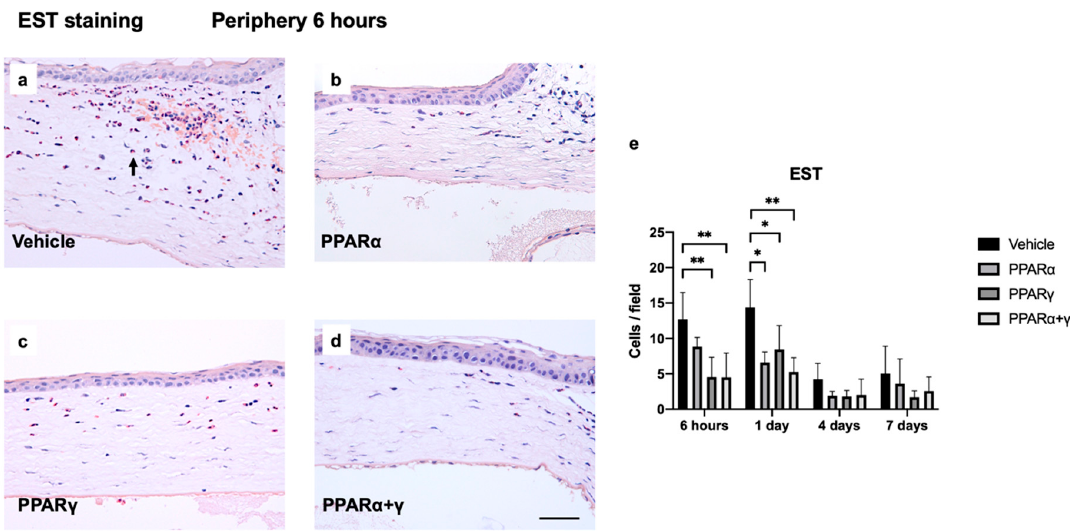
Figure 4. Esterase (EST) staining was performed to evaluate infiltrating cells in the rat cornea after alkali injury. Immunohistochemical images of the corneal limbus at 6 h are shown ( a – d ). Bar, 50 µ m. The black arrow indicates EST-positive cells ( a ). PPAR γ and PPAR α + γ treatment reduced the number of neutrophils in the peripheral cornea at 6 h. Bar chart of the number of EST-positive cells shows a statistically significant di ff erence between vehicle and PPAR treatments on day 1 ( e ). At 6 h after alkali burn, instillation of PPAR γ and PPAR α + γ agonists significantly suppressed neutrophils compared with vehicle and PPAR α instillation ( e ). Data are presented as the mean ± standard error ( n = 8 samples / group). ** p < 0.01, * p <